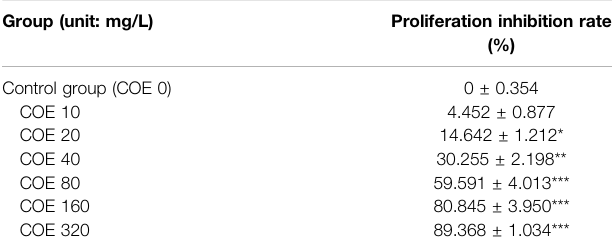
TABLE 1 | The effect of COE on the proliferation of gastric cancer AGS cells ( ‾ x ± s , n (cid:2) 5). Group (unit: mg/L)